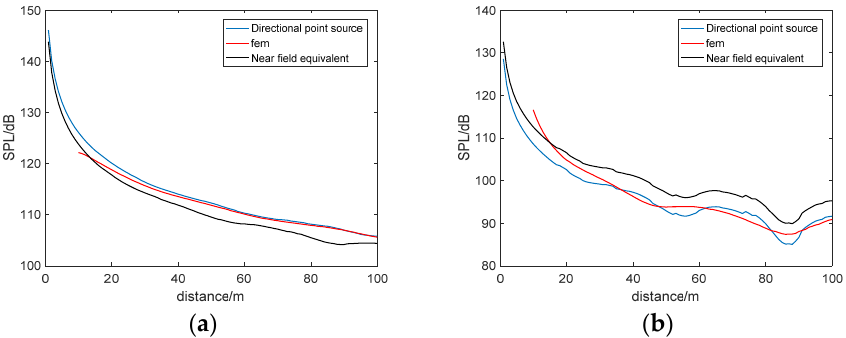
Figure 4. A comparison of the sound pressure of the scattering field calculated by the equivalent calculation of different near field and far field sound pressures and the result of direct finite element calculation: ( a ) 0°direction; ( b ) 80°direction.